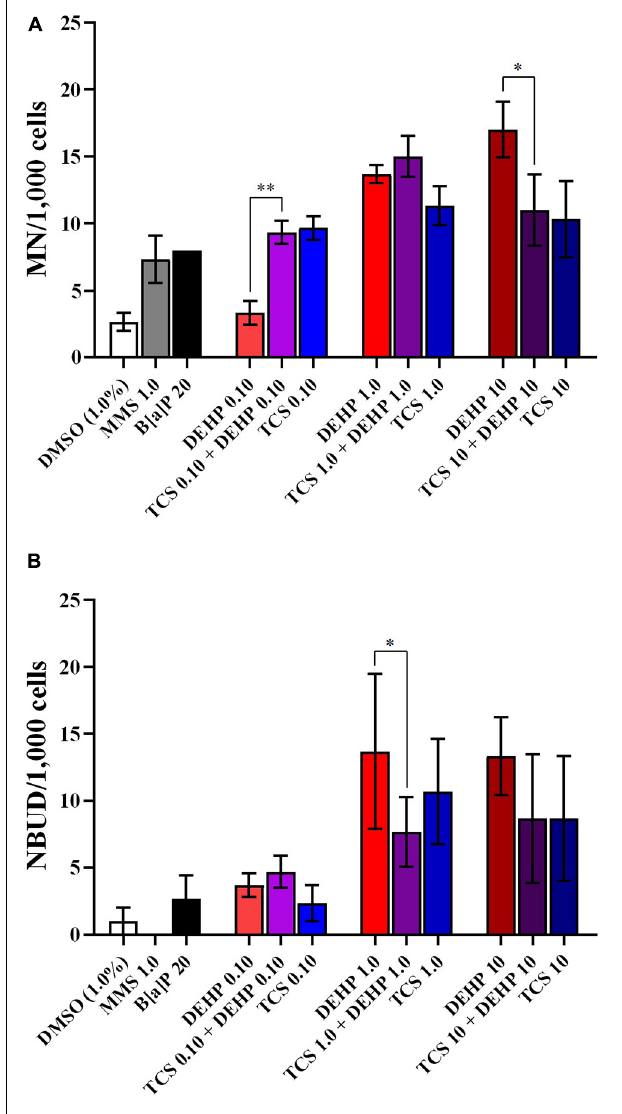
FIGURE 4 | Comparisons between the treatments with TCS + DEHP and their respective groups that receive TCS or DEHP alone, on parameters of DNA damage: (A) micronuclei (MN) formation and (B) nuclear buds (NBUDs) formation. All doses are in µ M. ∗ p < 0.050; ∗∗ p < 0.010; Wald’s chi-square tests followed by Bonferroni correction